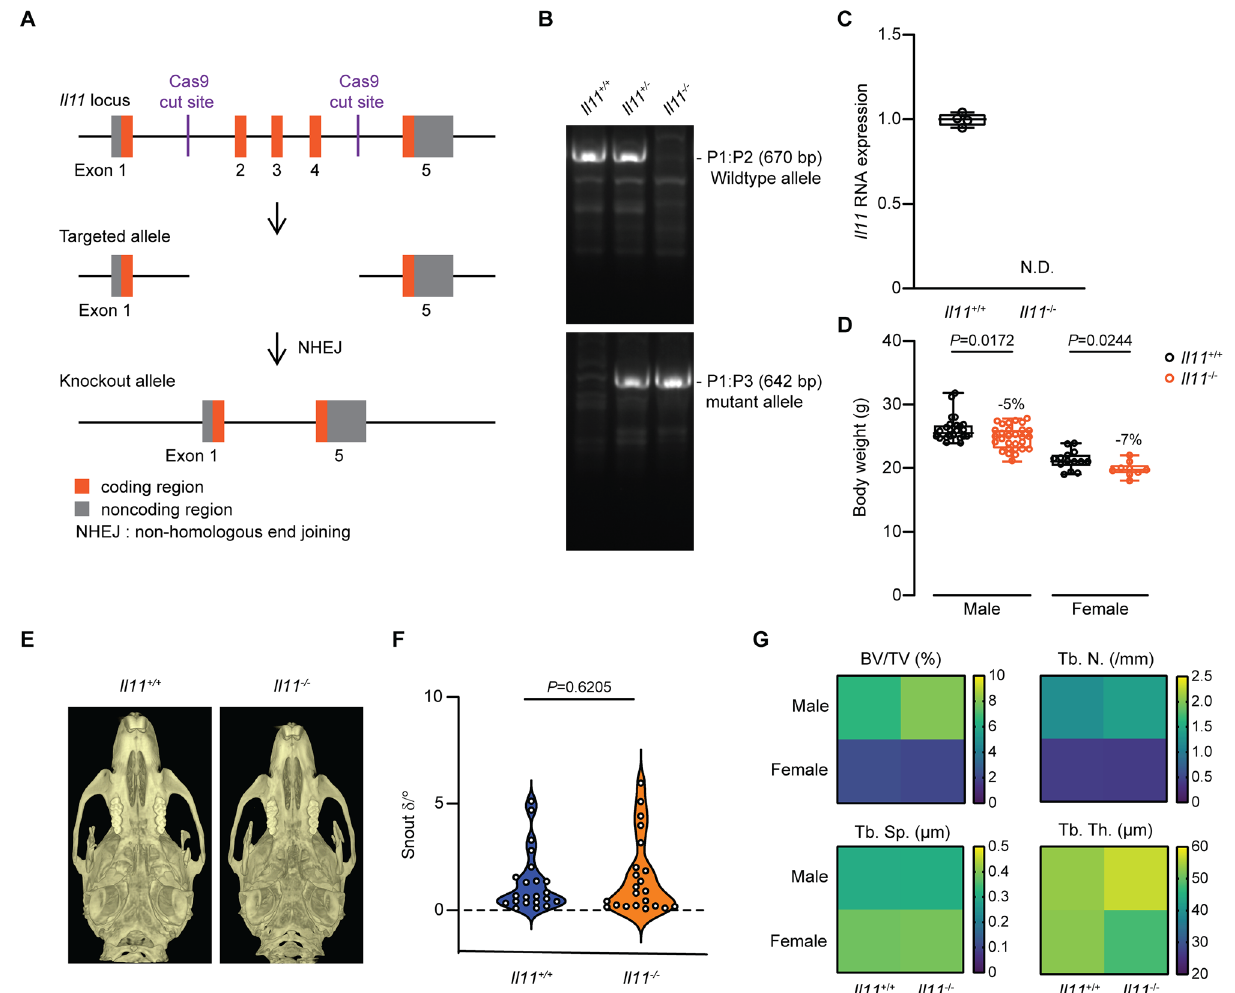
( D ) Body weight of 10–12 week old wild-type (male n = 26; female n = 14) and Il11 −/− mice (male n = 29; female n = 9). ( E ) Representative µCT images showing the ventral view of skulls from wild-type and Il11 −/− mice. ( F ) The degree of deviation from linear snout growth (δ/°) was determined in Il11 −/− as compared to wild-type mice ( Il11 + / + n = 23 and Il11 −/− n = 22). ( G ) Heatmaps showing the quantification of trabecular bone parameters of Il11 −/− and wild-type mice (12 weeks of age); n = 5–7 mice per genotype per gender and quantitative data are plotted in Supplementary Fig. S1. BV/TV, Trabecular bone volume per total volume, Tb.Th., trabecular thickness, Tb. N., trabecular number and Tb. Sp., trabecular separation. Data shown in C, D are: centre line, median value; box edges, 25th and 75th percentiles; whiskers, minimum and maximum values and data in F are shown as a violin plot. P values were determined by Student’s t